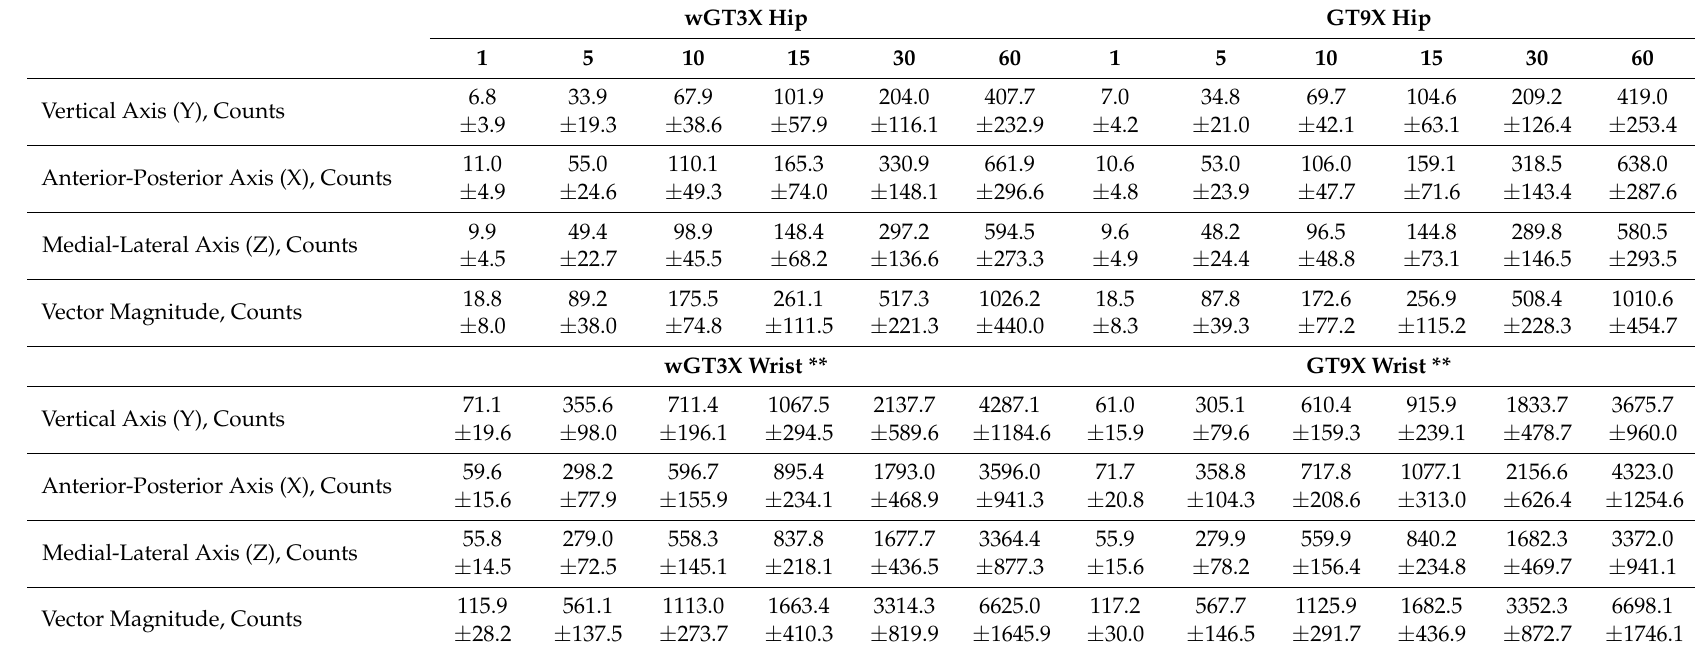
Table 2. Average of activity counts based on the six epoch